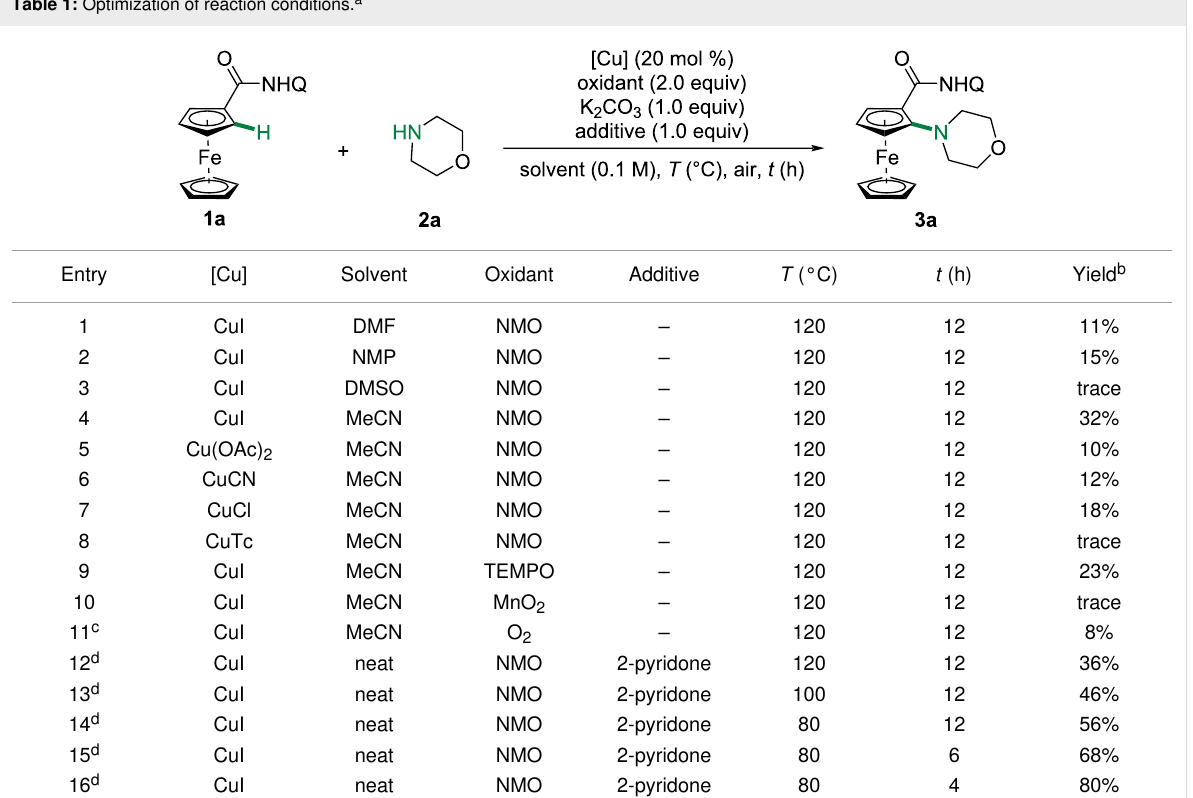
Table 1: Optimization of reaction conditions.